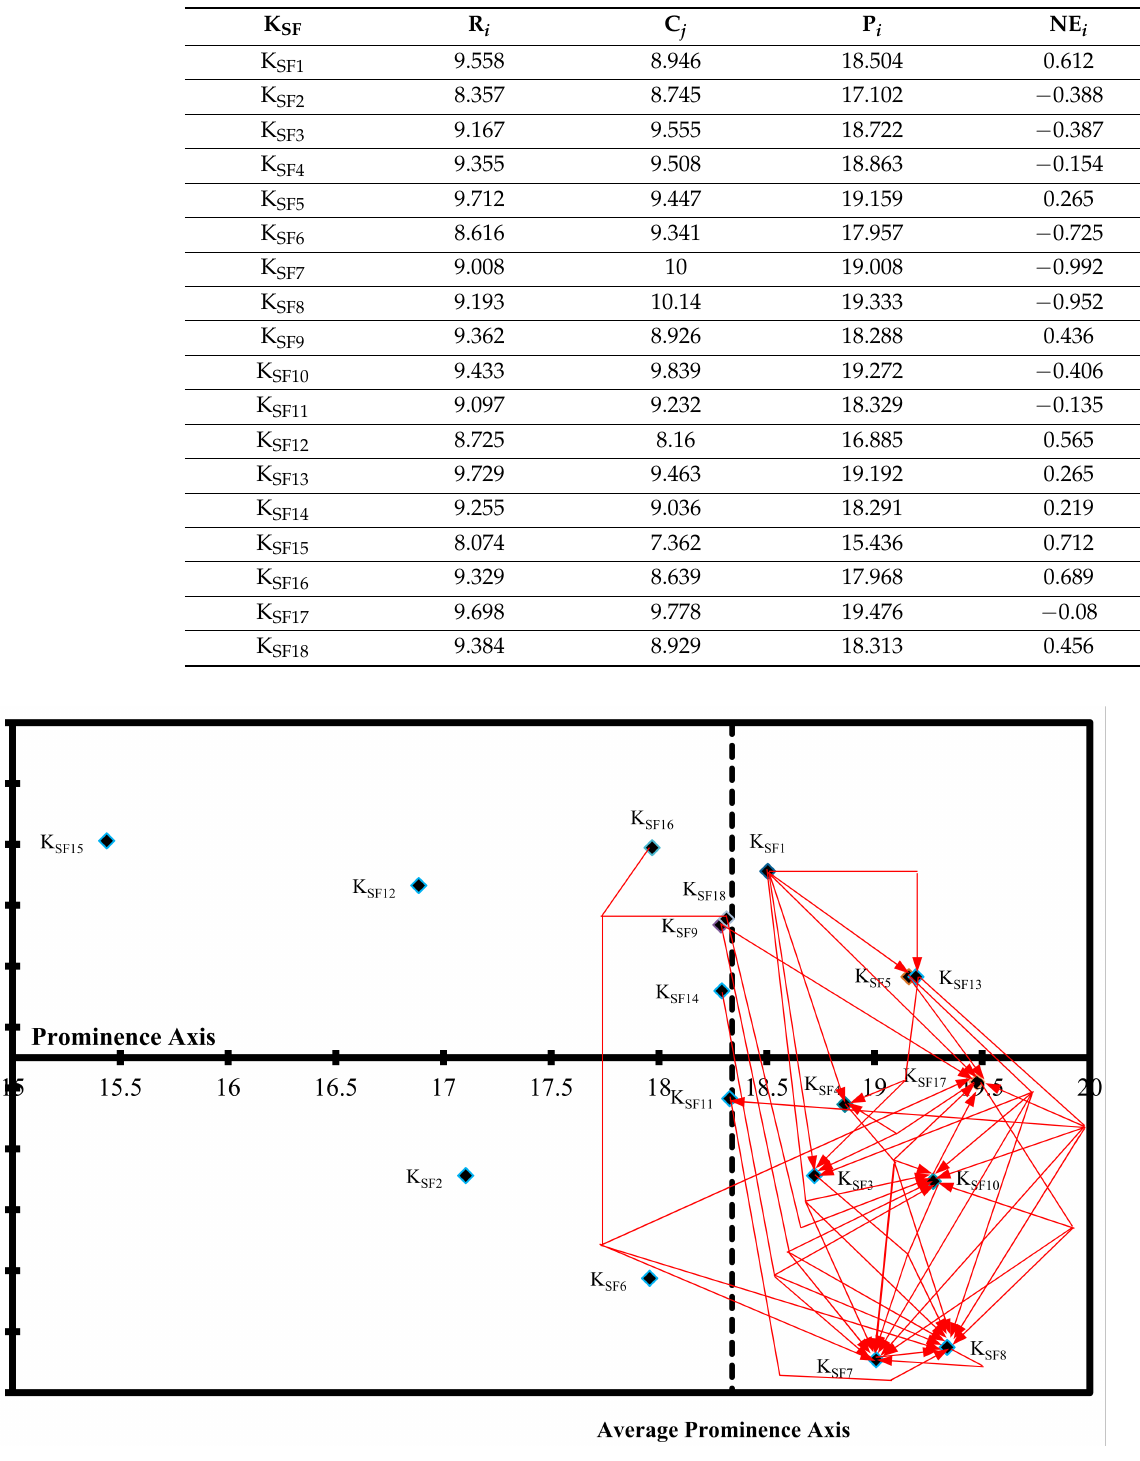
Figure 2. DEMATEL causal diagram of the KSFs of BIM